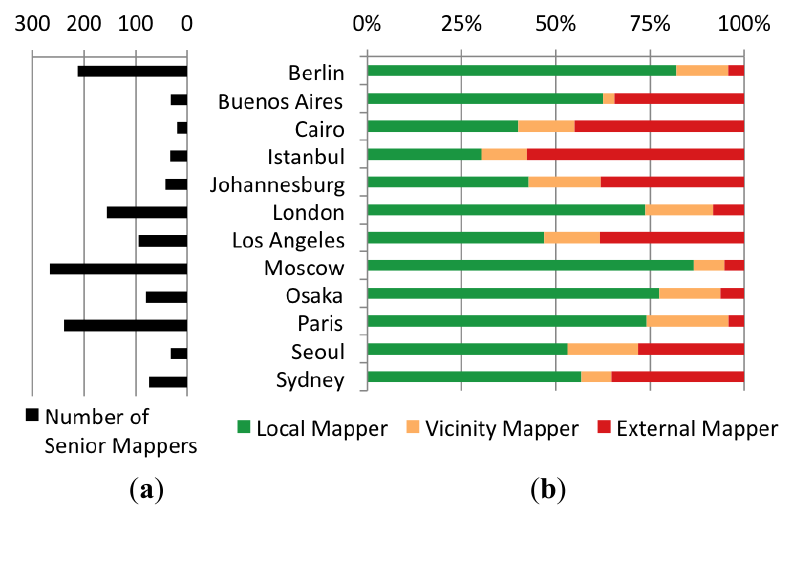
Figure 7. ( a ) Number of senior mappers per urban area; and ( b ) Distribution of senior local or external mappers per urban area (Oct.